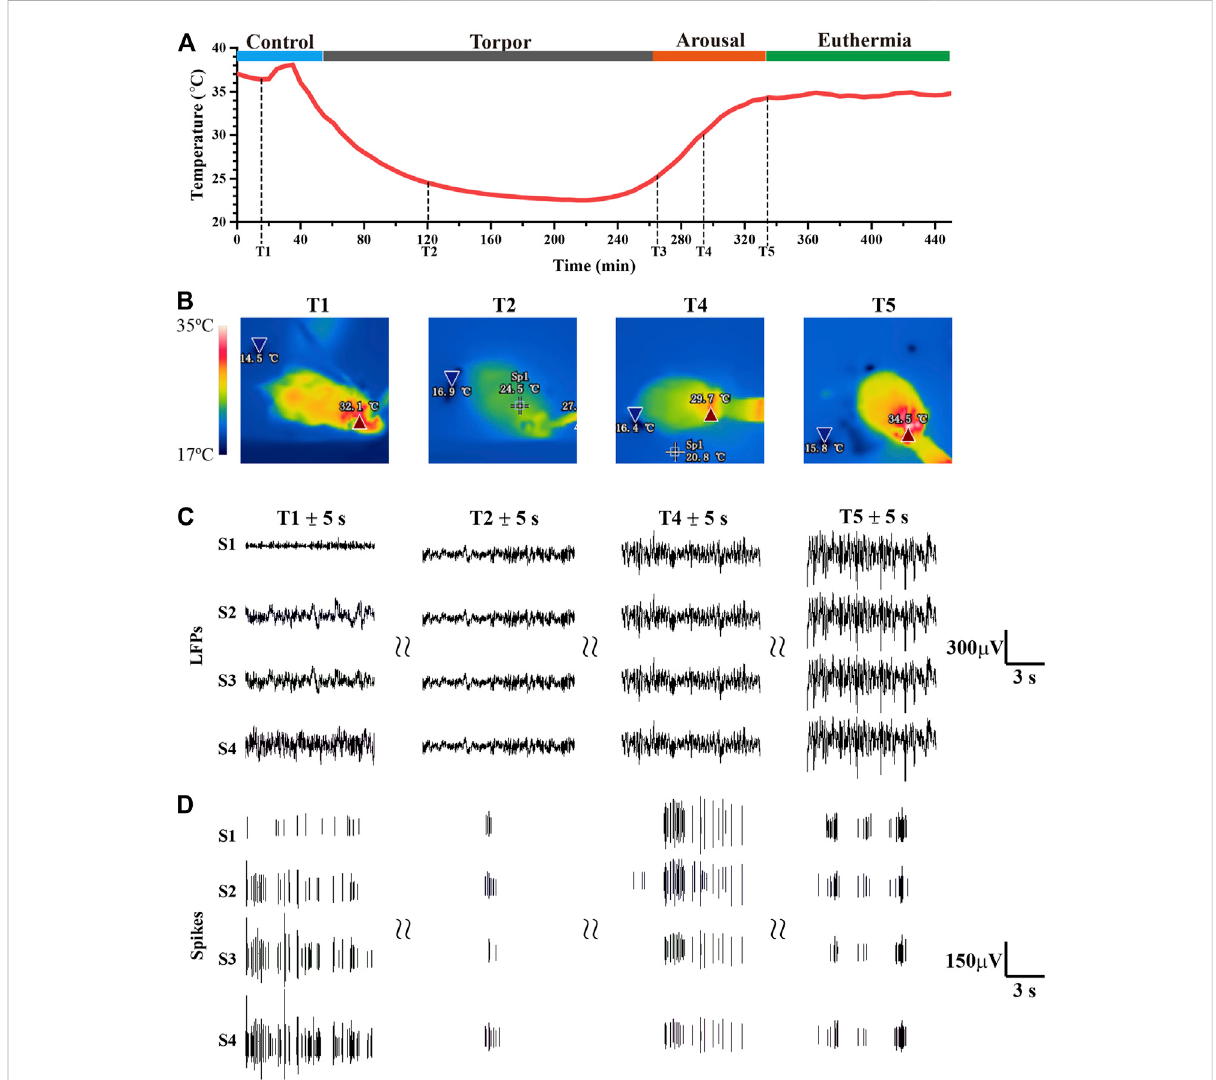
FIGURE 3 Simultaneous changes in core body temperature, infrared thermal images, electrophysiology signals from the whole experiment. (A) The real- timecorebodytemperatureinthetotalperiod(T1:25min,T2:118 min31s,T3:264 min,T4:290 min31s,T5:350 min23 s). (B) Theinfraredthermal imageswererecordedatdifferenttimestamps(T1,T2,T4,T5). (C,D) TheLFPs,spikewererecordedbyS1-S4,whichwasexcerptedfromT1±5s,T2± 5s, T4 ± 5s, T5 ± 5s, respectively (S1-S4 represent four example